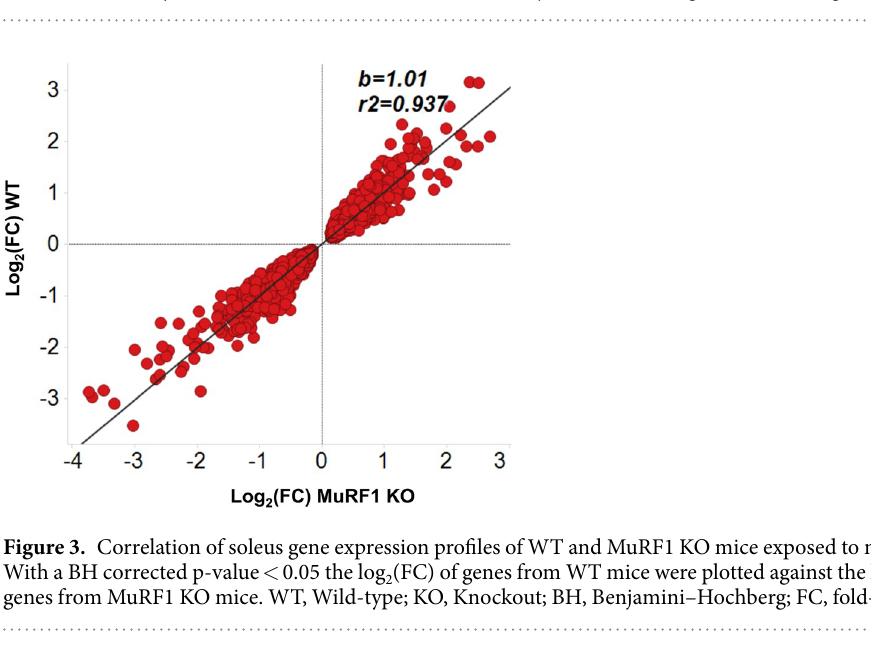
KO mice, respectively (Fig. 2b,d; 2 fold change, adjusted p < 0.05). Due to the paucity of differentially regulated genes in the gastrocnemius, we henceforward focused exclusively on expression profiling of the soleus. We next interrogated transcriptome profiles of WT and MuRF1 KO mice to identify differences (or similari- ties) in individual genes affected by microgravity exposure. Using 2-fold change and < 0.05 adjusted p value cutoff we observed a gene correlation with a slope of 1.01 and r 2 of 0.937 (Fig. 3); indicating a large degree of similarity in gene expression profiles between WT and KO mice and corroborating the lack of efficacy observed in MuRF1 KO mice subjected to microgravity. MuRF1 KO Mitigates Muscle Loss Induced by Hindlimb Immobilization. Rodent hindlimb immo- bilization and hindlimb suspension are ground-based models that are often used to simulate the effects of micro- gravity exposure on the musculoskeletal system. In spaceflight, immobilization and hindlimb suspension, the